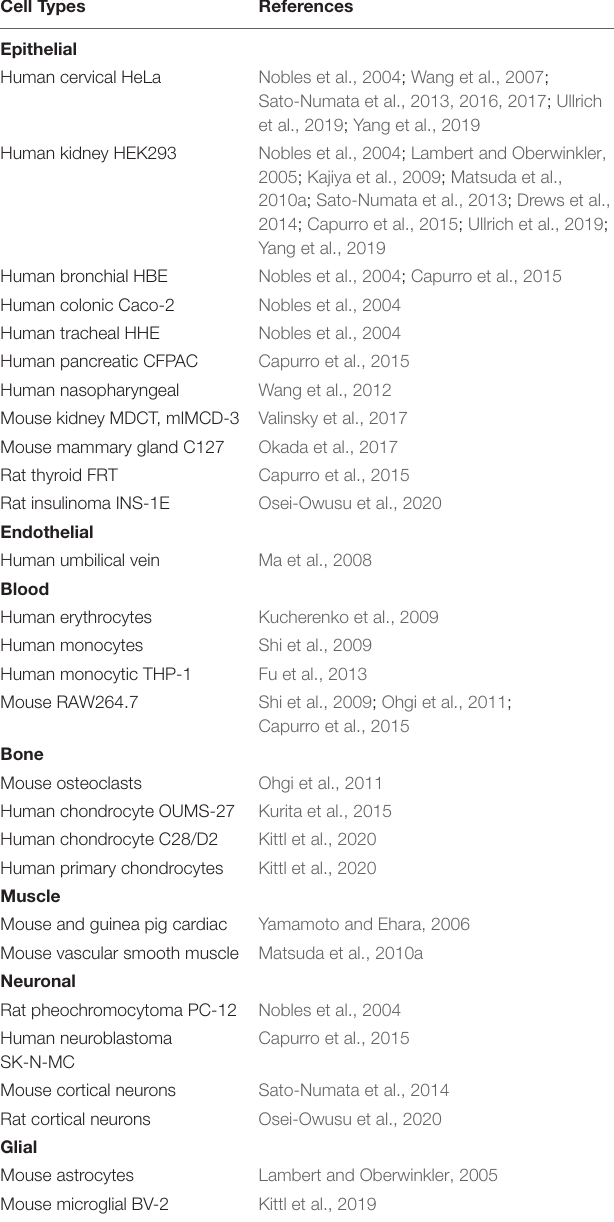
TABLE 1 | Cell types exhibiting functional expression of ASOR/PAC channel